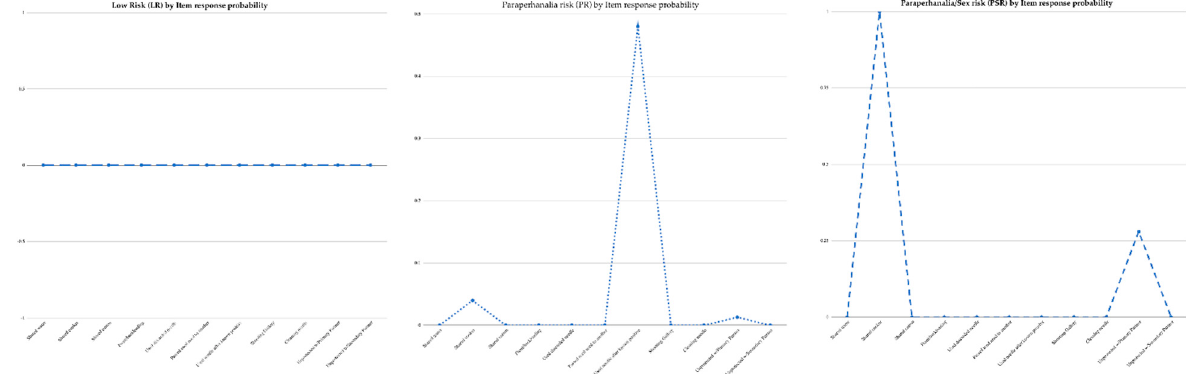
Figure 1. Latent class